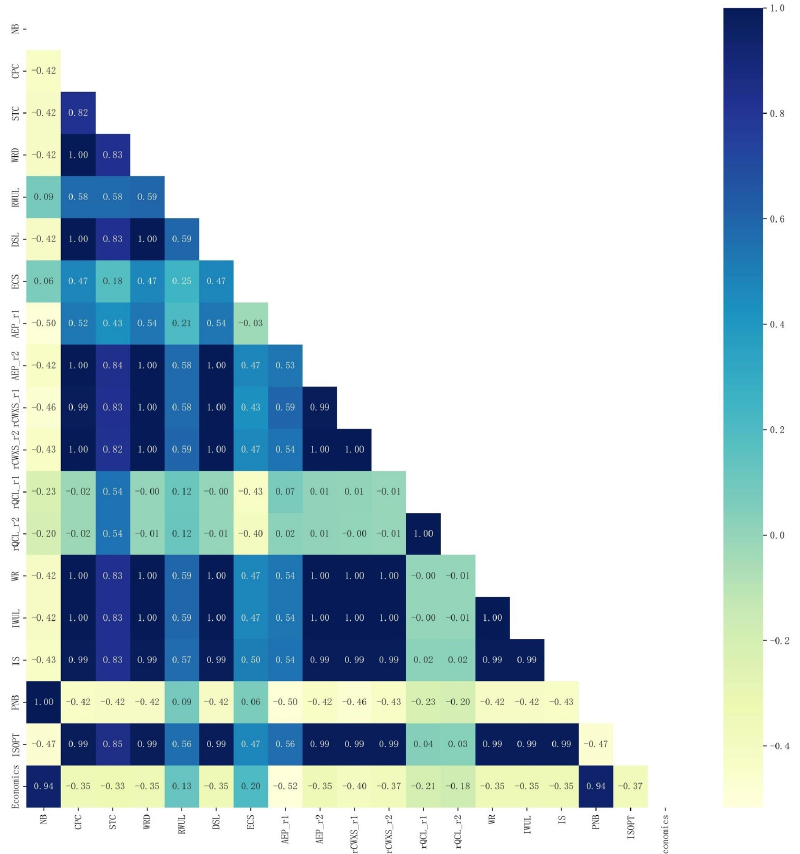
Figure 7. Correlation between variables and economic benefits in the IFTSC model.